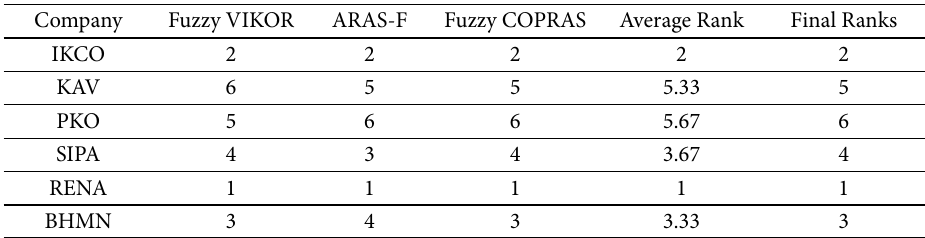
Table 8. Final Rankings of the companies Company Fuzzy VIKOR